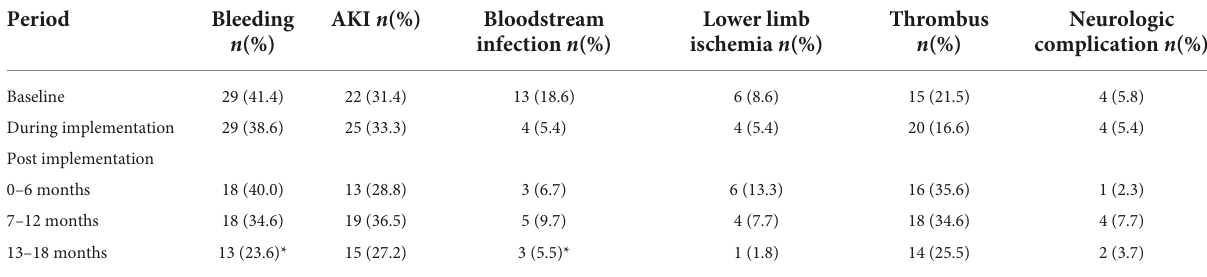
TABLE 3 Incidence of complications during extracorporeal membrane oxygenation (ECMO) from baseline to 18 months of follow-up. Period